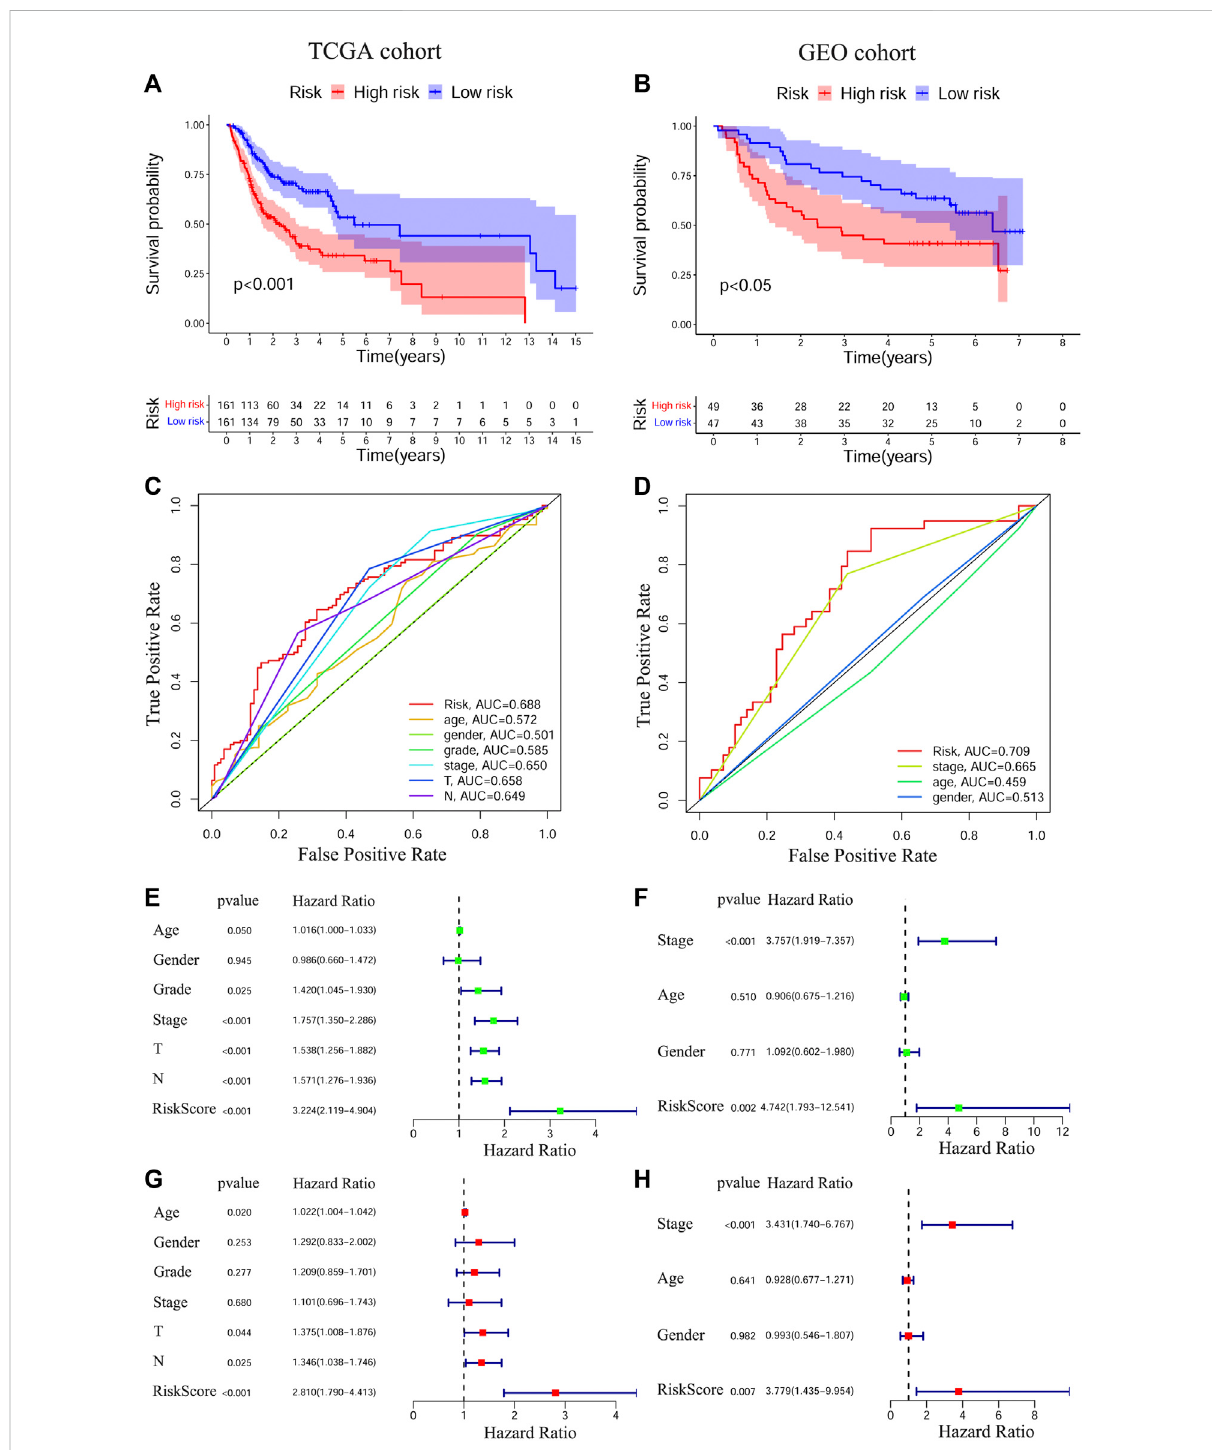
FIGURE 2 Prognosticanalysesoftheconducted signatureinOSCCbasedonTCGAandGEOcohorts.TheKaplan – Meiersurvivalcurvesoftheprognostic signature in TCGA (A) and GEO (B) cohorts. The ROC curves and AUC values of the signature and clinical features in TCGA (C) and GEO (D) cohorts. Univariate Cox regressionanalysesofthesignature and clinicalfeaturesinTCGA (E) andGEO (F) cohorts.Multivariate Coxregression analyses ofthe signatureandclinicalfeaturesinTCGA (G) andGEO (H) cohorts.OSCC,Oralsquamouscellcarcinoma,TCGA,TheCancerGenomeAtlas,GEO, The Gene Expression Omnibus, ROC, Receiver operating characteristic, AUC, Area under